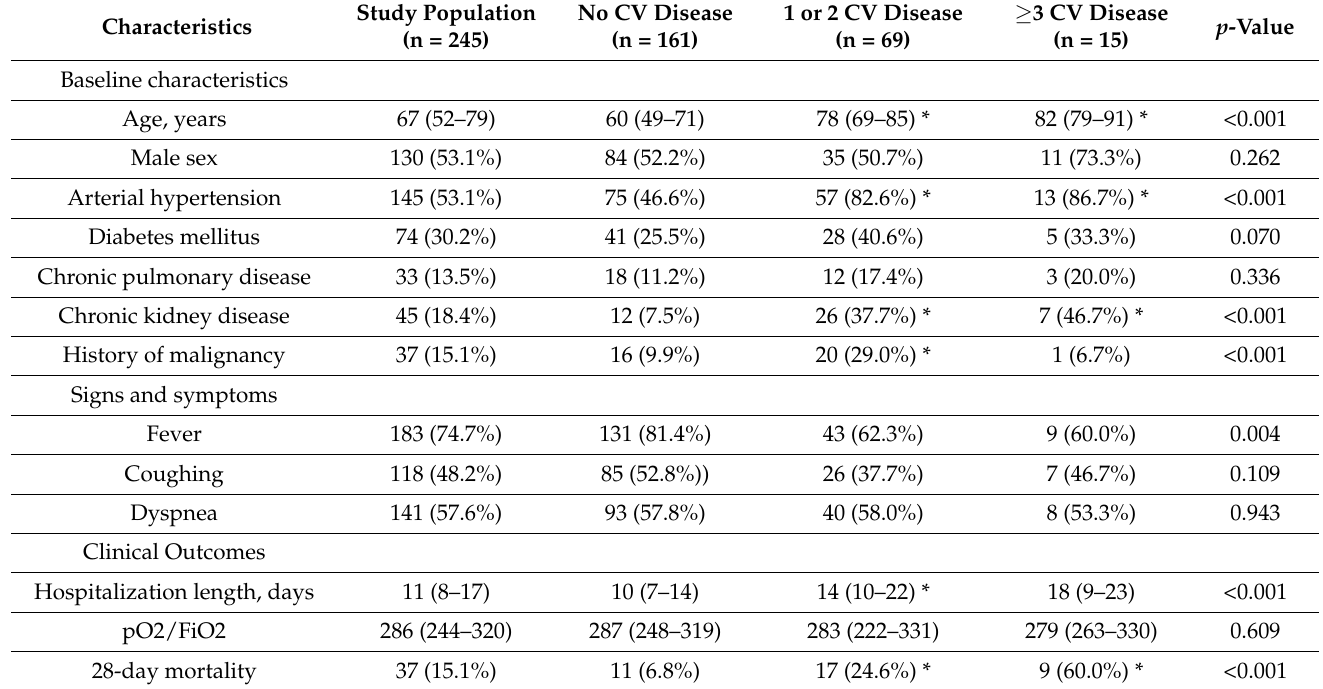
Table 1. Baseline characteristics and clinical outcomes of the study population stratified by CV disease. * indicates a significant difference to those without CV disease after Bonferroni